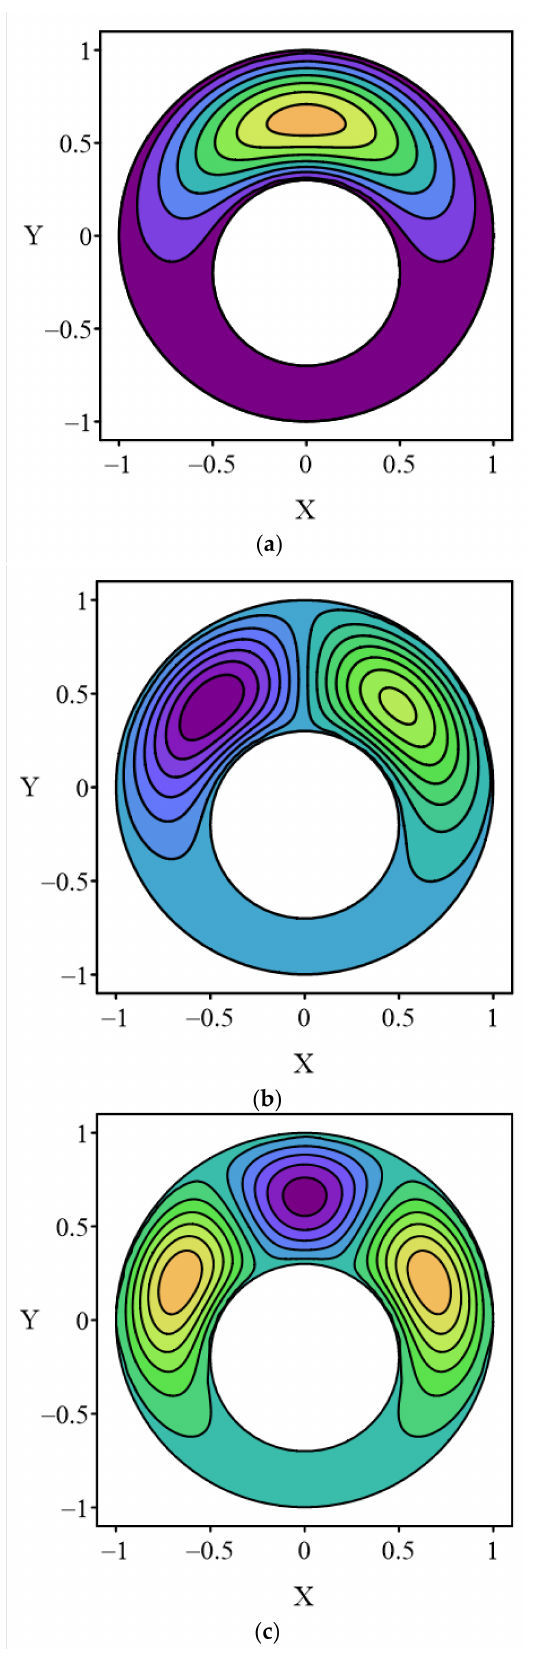
Figure 10. The first three eigenmodes for eccentric annular waveguide (TM wave): ( a ) k 1 = 4.8106, ( b ) k 2 = 5.5113, and ( c ) k 3 =